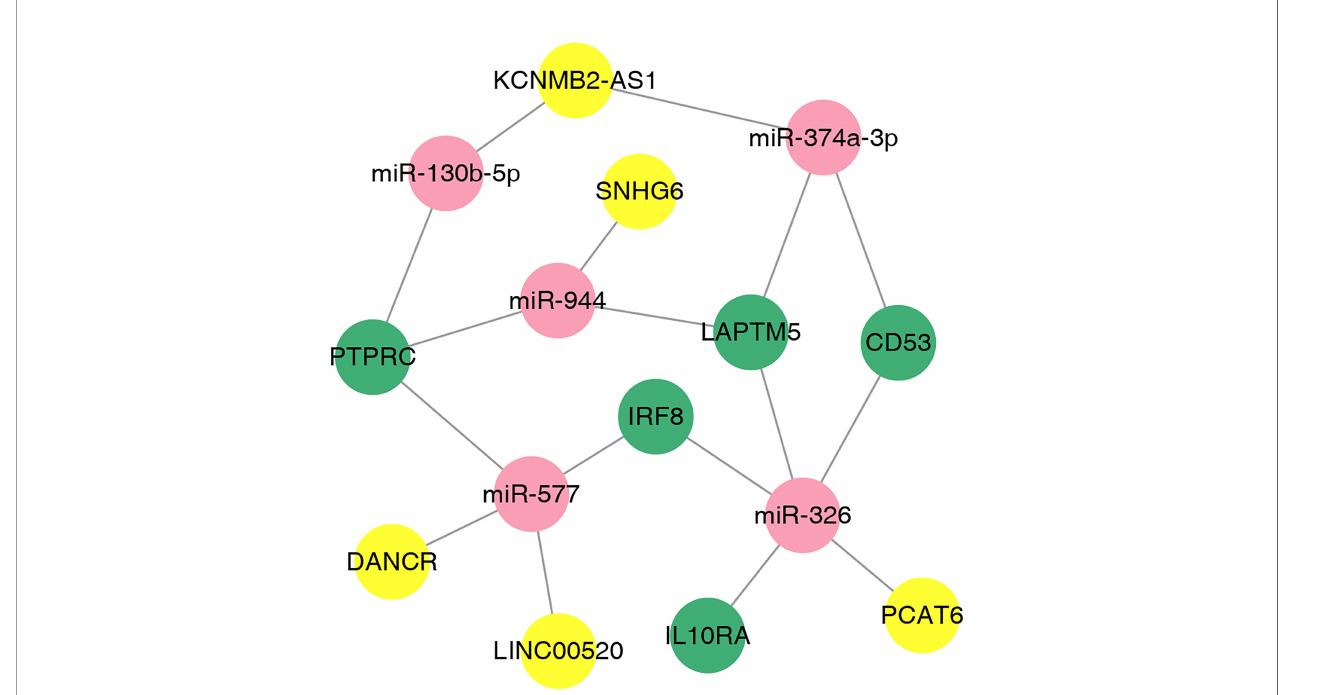
FIGURE 9 | The lncRNA – miRNA – mRNA ceRNA network in DN. The nodes colored in yellow, red, and green represent lncRNAs, miRNAs, and mRNAs, respectively.